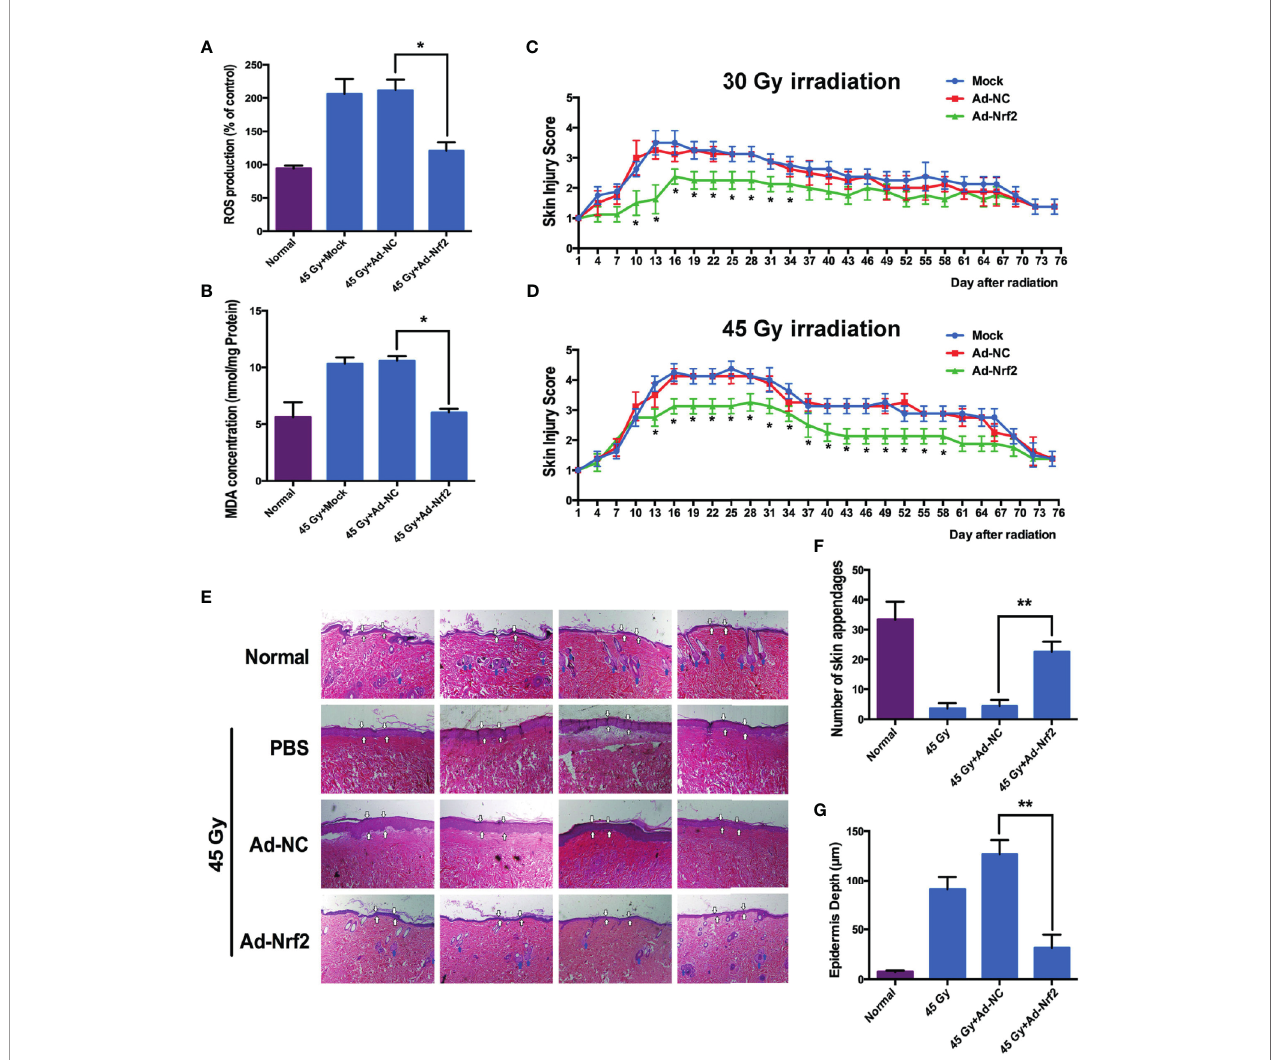
FIGURE 4 | Nrf2 overexpression ameliorates radiation-induced skin injury in rat models. Rat gluteal skin was irradiated with an electron beam followed by subcutaneous injection of control adenovirus, Nrf2 adenovirus or PBS (six animals per group). (A) ROS levels in rat skin tissues from the irradiated area were detected 3 days after IR. (B) Lipid peroxidation of rat skin tissues from the irradiated area was detected using MDA 3 days after IR. (C, D) Skin injury was measured using a semiquantitative score of 1 (no damage) to 5 (severe damage). (E) Representative hematoxylin and eosin (HE) staining of rat skin at 75 days after irradiation. (F) Number of skin appendages in each group. (G) Epidermal thickness in each group. * means p < 0.05, ** means p <